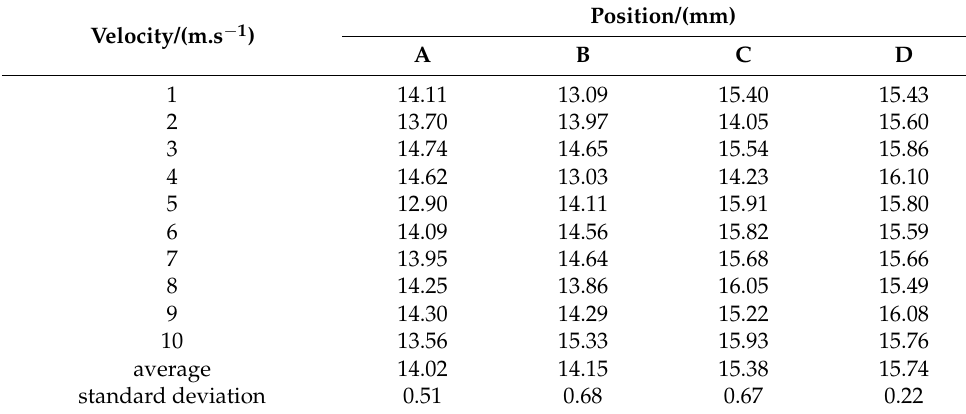
Figure 6. Measuring point position map. ( a ) Location distribution of measuring points; ( b ) test device diagram. Table 3. Export speed 10 measurements and their average .